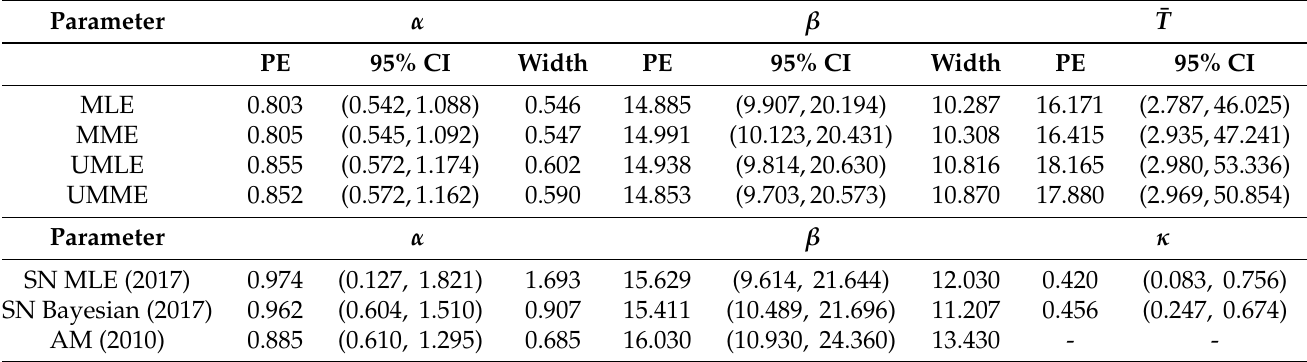
Table 1. Parameter estimates on cancer